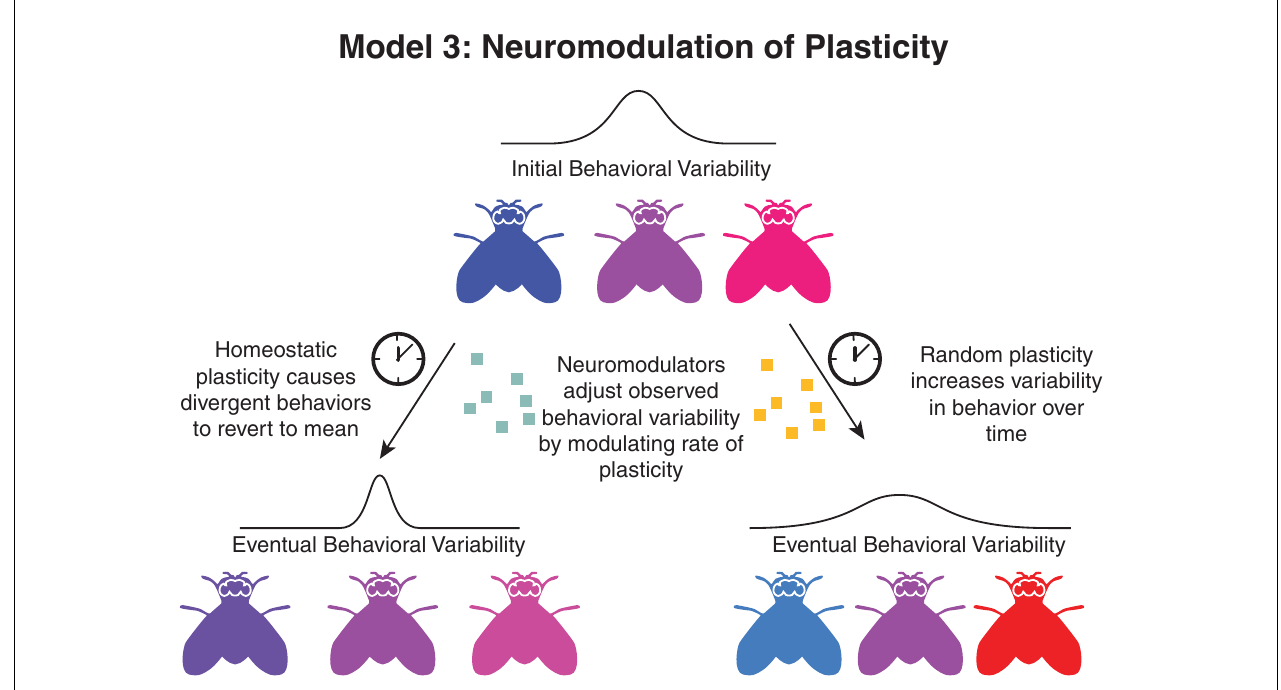
FIGURE 3 | Neuromodulation as a regulator of variability through plasticity. In this model, variability is driven by changes in the variability of underlying circuit components over time, either in a homeostatic mechanism (left) moving behavior closer to a predetermined set point, or through a divergent method (right), leading to further deviation from parameters determined during